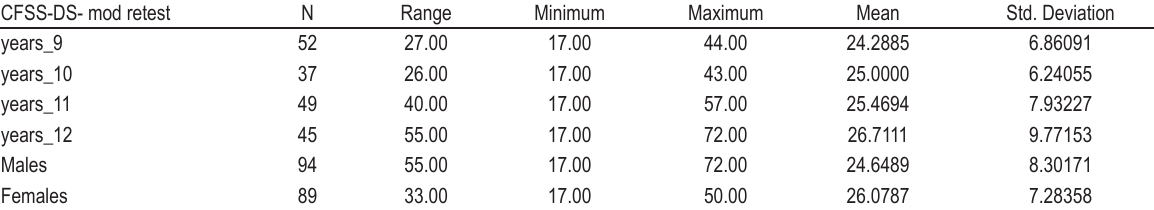
TABLE 4. Descriptive values of the results on the CFSS‑DS‑mode scale concerning the age and sex of the retest group